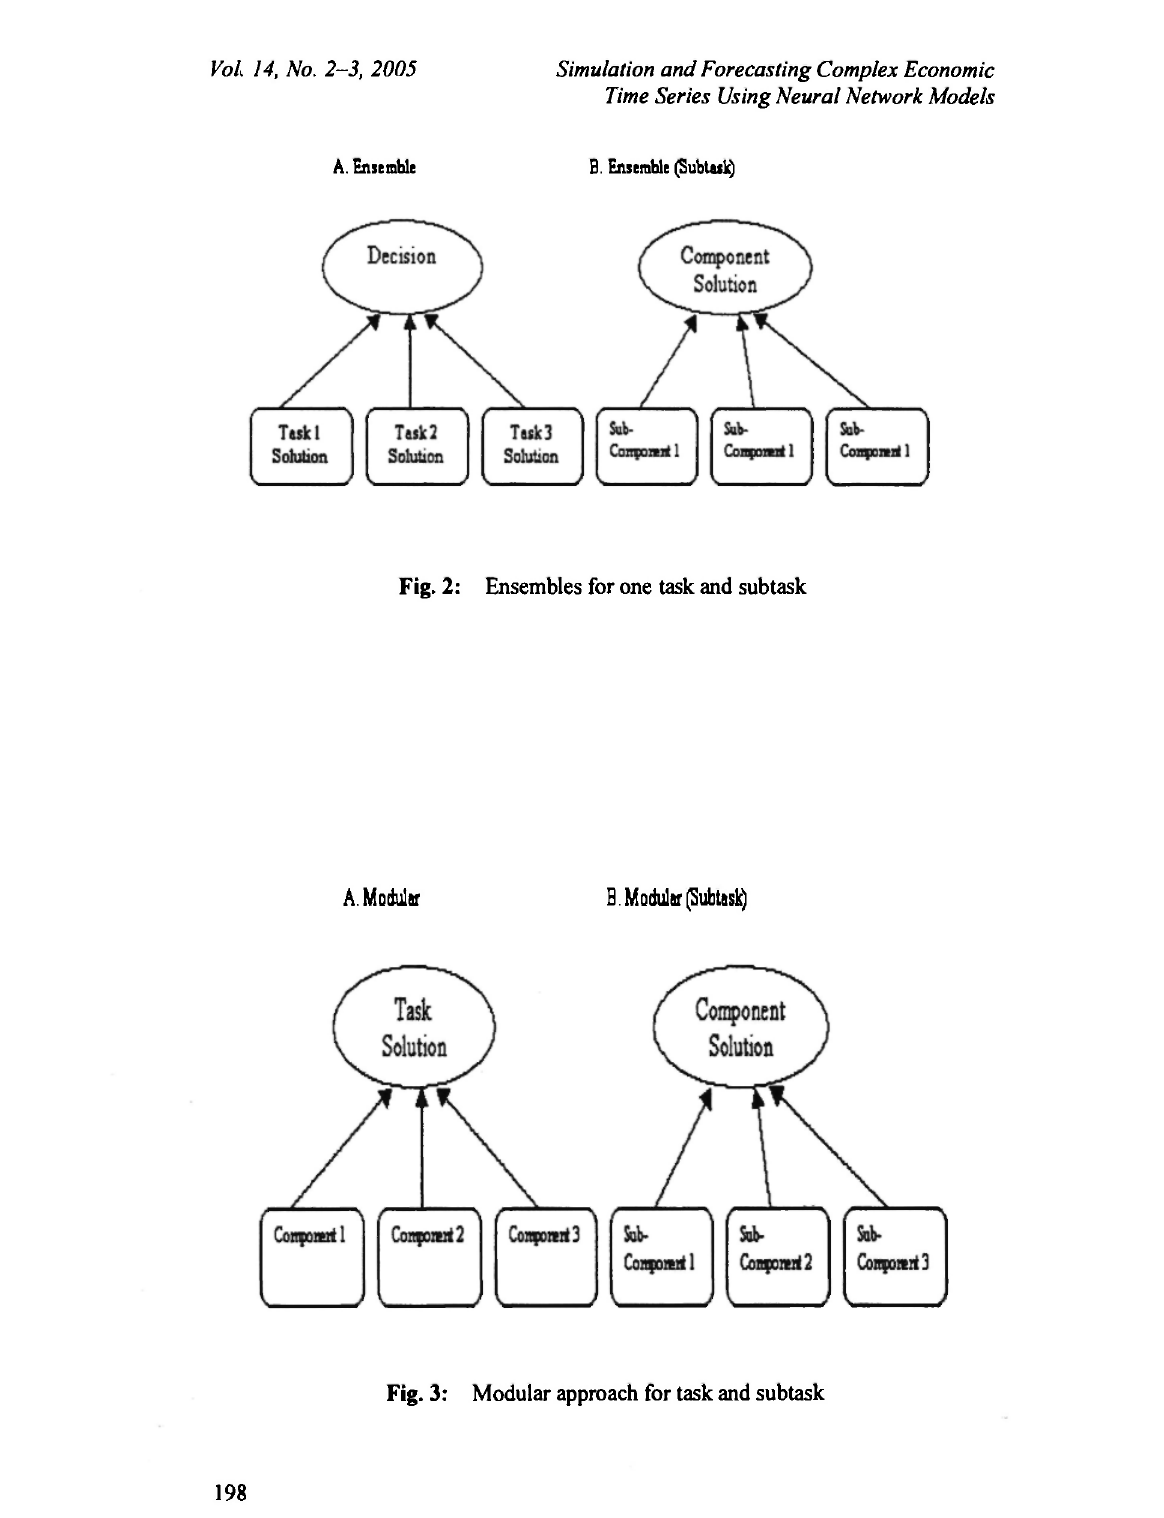
Fig. 3: Modular approach for task and